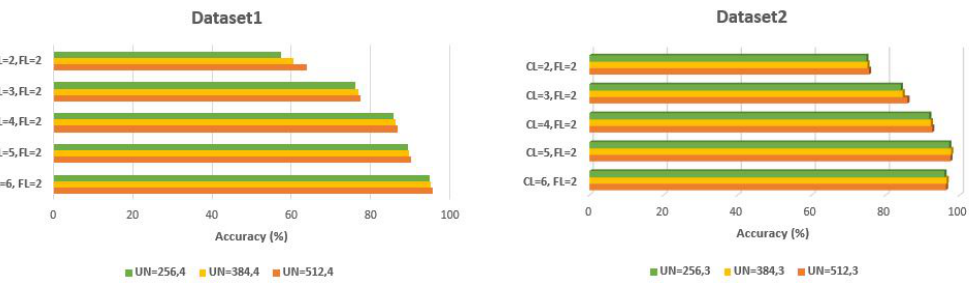
Figure 12. Impact of CL and UN in the dense layers on classification accuracy.